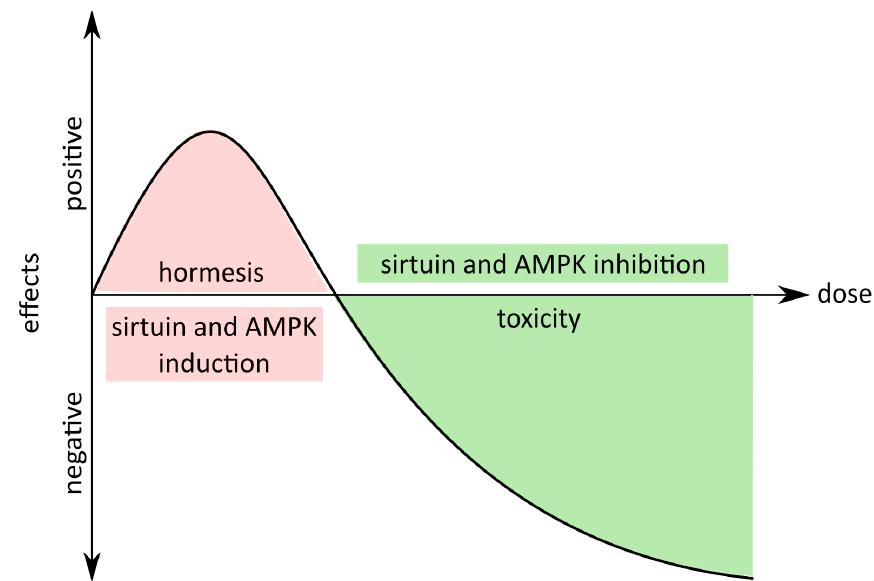
Figure 1. Hormetic properties of curcumin. Low doses of curcumin exert positive effects at the organismal (life extension) and cellular level (activation of sirtuins and AMP-activated kinase (AMPK)); however, at higher doses, curcumin can be toxic or cytostatic (inhibition of sirtuins and AMPK).